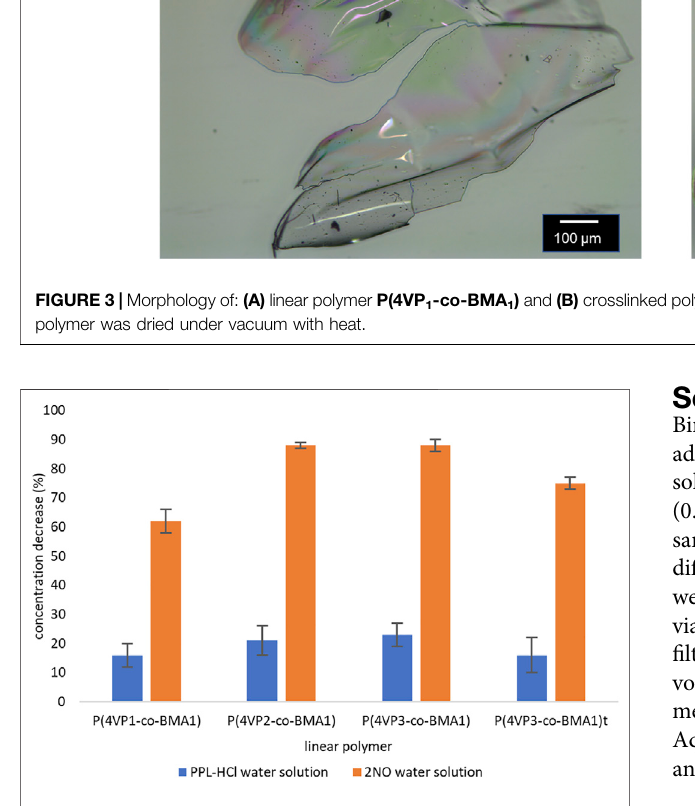
FIGURE 4 | Decreases in concentrations of contaminants following binding experiments for linear polymers.